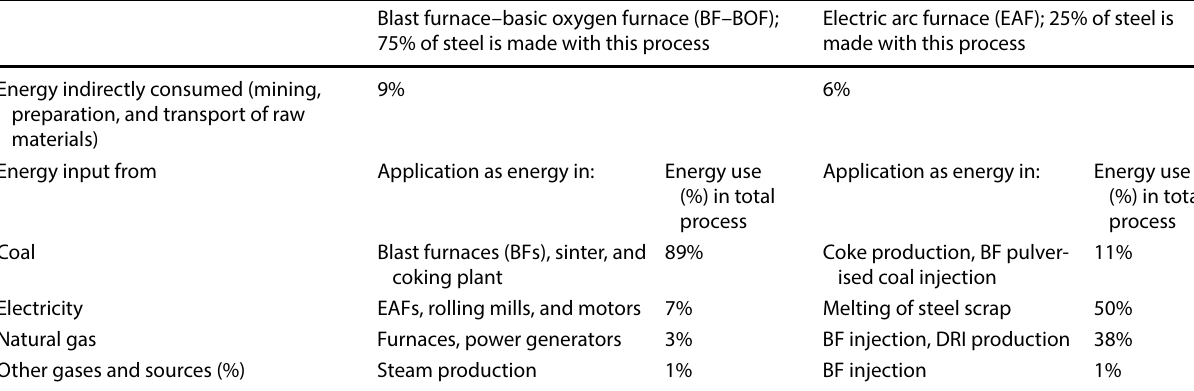
BF–BOF production of primary steel from iron ore (oxygen is blown through liquid pig iron, increasing its temperature and releasing car- bon), EAF production of secondary steel from scrap